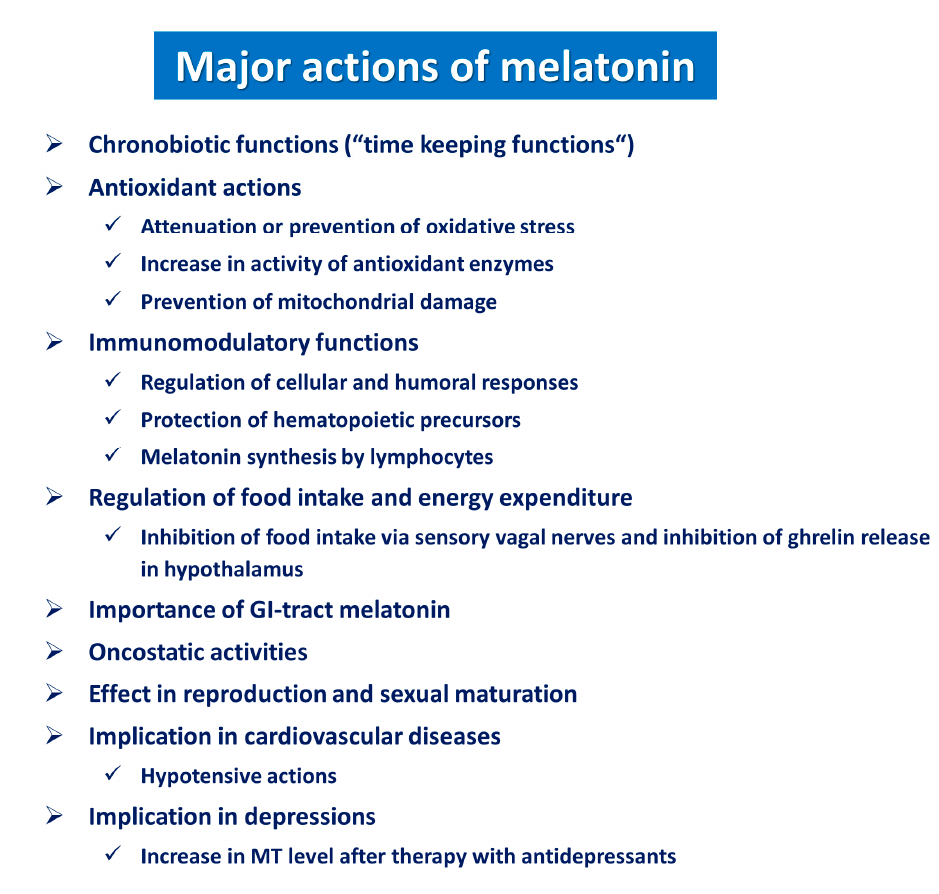
Figure 3. A summary of the pleiotropic actions of melatonin in gastrointestinal and extra-gastrointestinal organs. Besides regulating the circadian rhythm, melatonin plays an important role in the mechanism of protection of gastrointestinal organs including the esophagus, stomach and intestine.